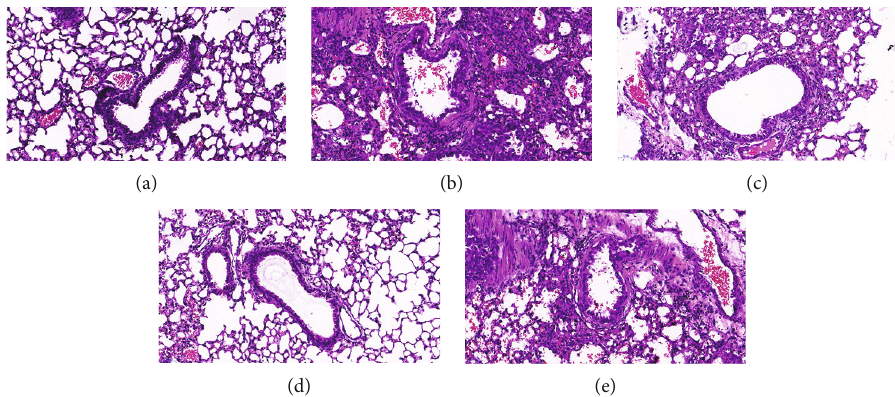
Figure 3: The e ff ect of YPG on bronchial asthma in rats. Sections were stained with H&E. Magni fi cation, × 400; scale bars, 50 μ m. Normal group (a), model group (b), YPG group (c), GK group (d), and pathway blocker group (e).